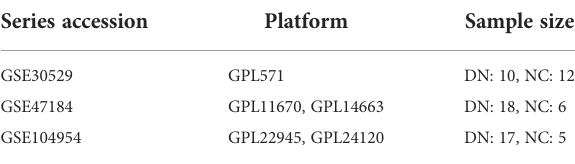
TABLE 1 Summary of diabetic nephropathy studies on kidney tubules and associated microarray datasets from the Gene Expression Omnibus